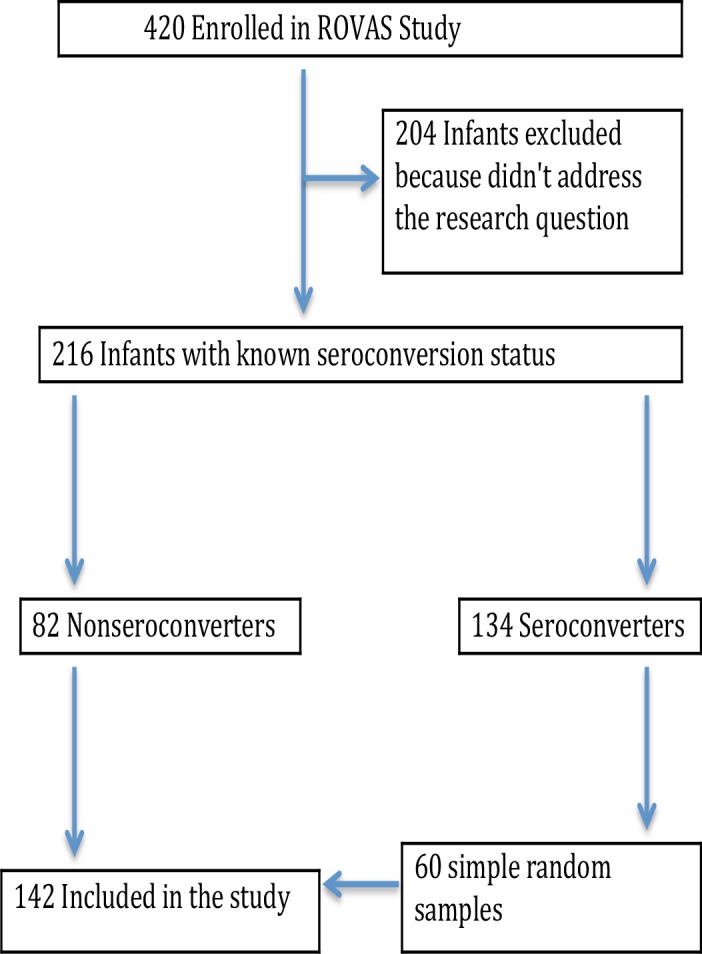
Infant recruitment and sample selection flow chart.